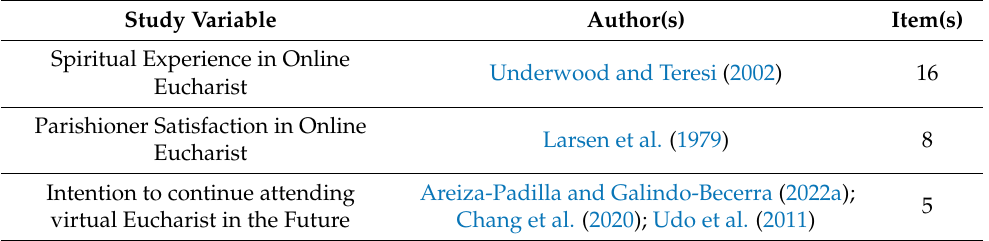
Table 3. Sources of measured items.